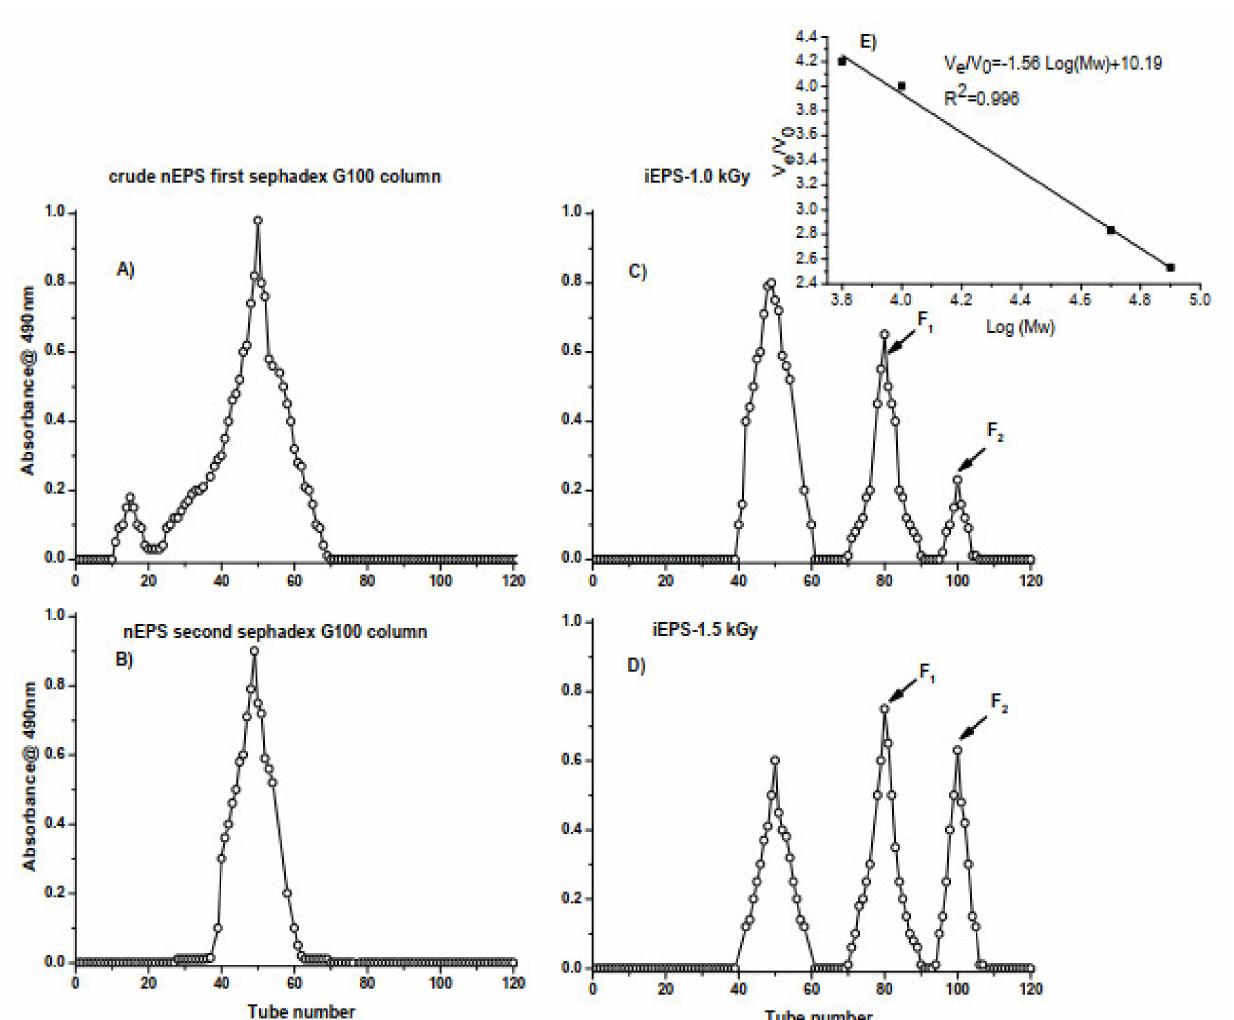
Figure 3. Elution curves of crude nEPS ( A ), purified nEPS ( B ), and gamma-irradiated derivatives iEPS 1 kGy ( C ) and iEPS 1.5 kGy ( D ) by Sephadex G-100 gel filtration. The volume of each fraction was 2 mL, and the eluates were checked by measuring the absorbance at 490 nm, ( E ) standard curve of the relative molecular weight (MW).